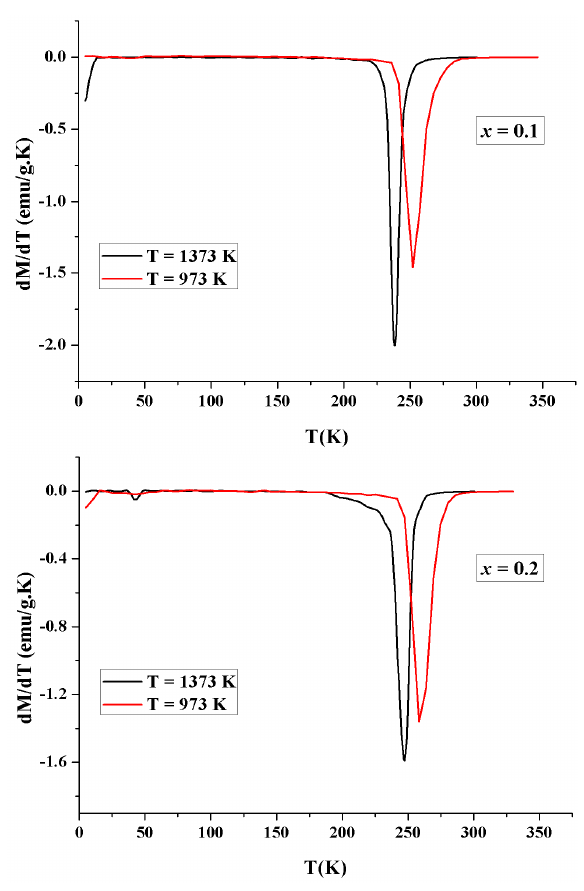
Figure 3. Comparison of the temperature dependence of ( − dM/dT) measured for an applied magnetic field of 0.5 T for La 0.8 − x (cid:0) x Ca 0.2 MnO 3 ( x = 0, 0.1 and 0.2) compounds annealed 1473 K and 973 K.